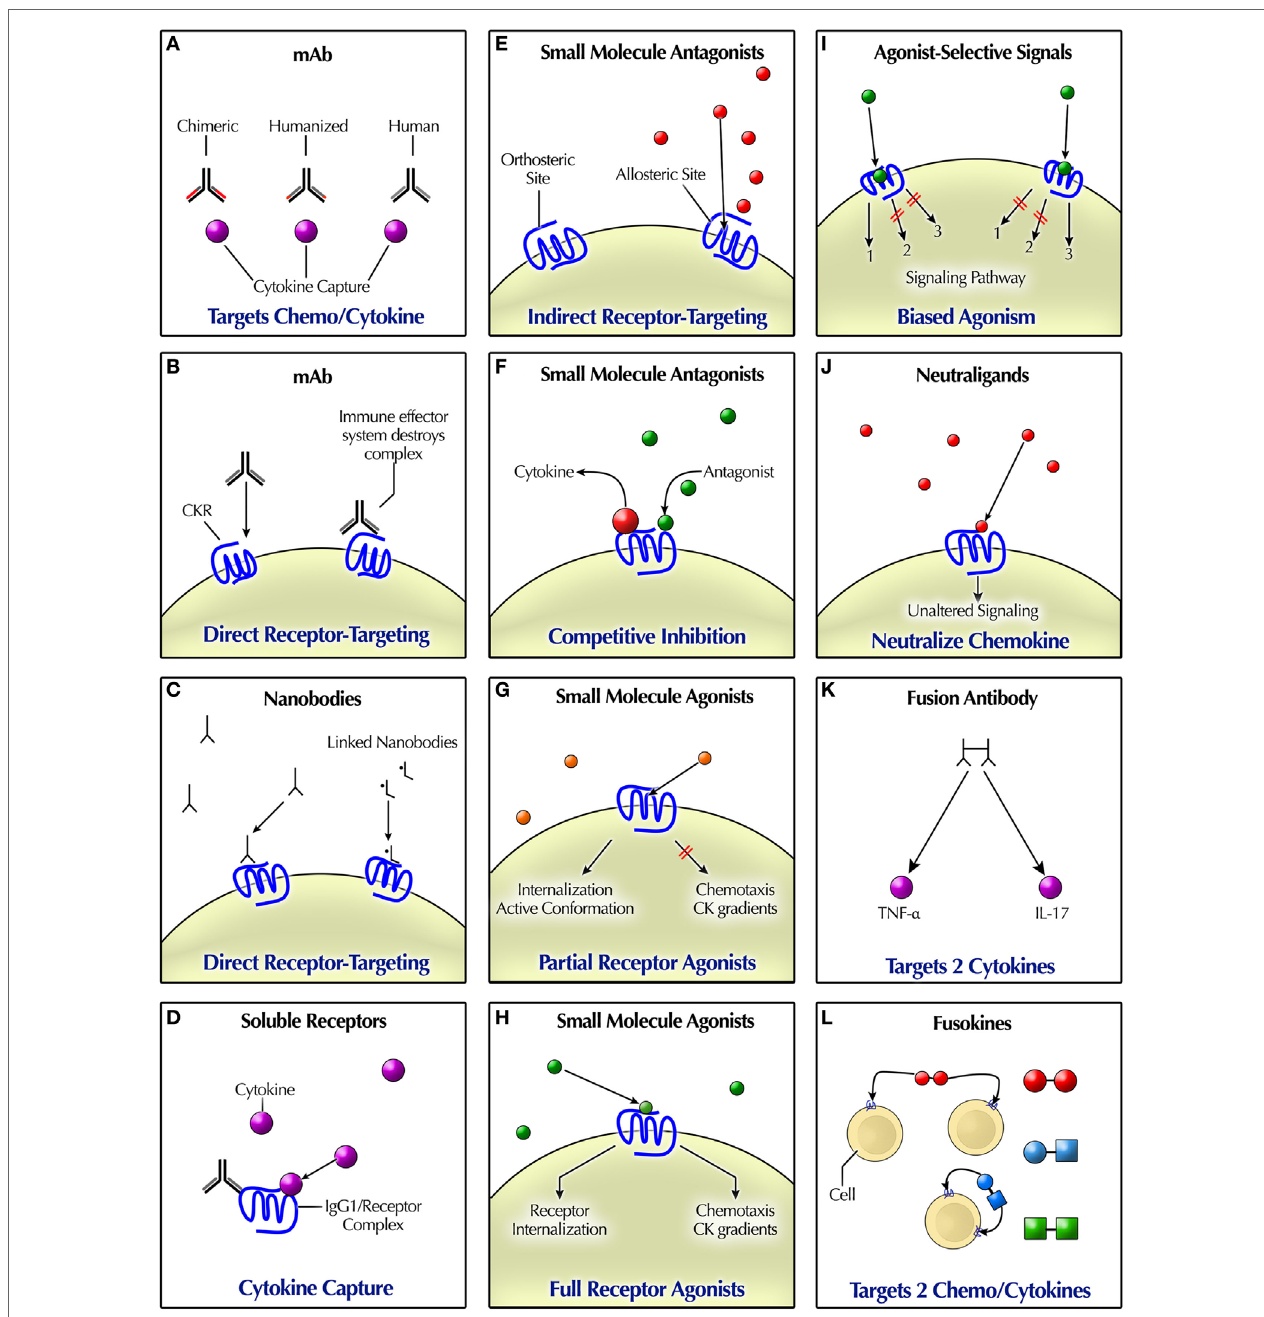
FiGURe 2 | Modalities for pharmacologically targeting chemokine (CK)/cytokine ligands and receptors. (A) mAbs can bind to CKs or other cytokines. (B) Some mAbs mimic natural ligand binding, acting as agonists or antagonists. The effector immune system removes mAb-targeted cells. (C) Nanobodies are engineered “miniature” antibodies. (D) Soluble CKR may occur naturally, or they can be engineered as a recombinant fusion protein. Delivery of soluble receptors that bind ligands takes them out of play. (e) Indirect receptor targeting or functional antagonism refers to indirect antagonism, such as via binding to an allosteric site. By contrast, CKs usually bind at the primary (orthosteric) receptor site, indicative of a syntopic interaction. Some small molecule antagonists bind at an allosteric site. Allosteric agents may possess agonist, antagonist, or neutral effects. (F) Competitive inhibition or antagonism occurs when agonist and antagonist binding are mutually exclusive, such as if competing for the same binding site. Non-competitive antagonism refers to the occurrence of agonist and antagonist binding simultaneously. (G) Partial agonists have the capacity to produce some but not all of the effects of a full agonist. Their receptor binding may trigger receptor internalization, but perhaps not immune cell chemotaxis or a CK gradient. An inverse agonist reduces the number of receptors in active form. (H) A high-efficiency full agonist need only occupy a fraction of total receptors, leaving the rest “spare.” (i) Agonist-selective signaling may trigger different signaling based on biased agonism at the receptor. (J) Neutraligands bind to the receptor without altering cell signaling. Depicted are small molecules; however, neutral antibodies also exist. (K) Fusion antibodies are bispecific, designed to target two differernt cytokines. (l) Fusokines either target two cytokines, such as tumor necrosis factor (TNF)- α and IL-17, one cytokine and one CK, or two CKs, such as CXCL10 and XCL1.